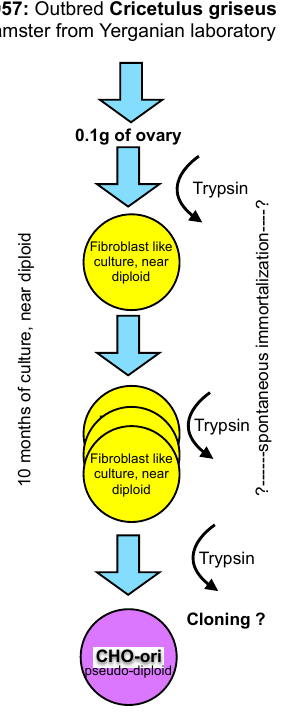
Figure 1. A scheme representing the generation of the early “original” CHO cell